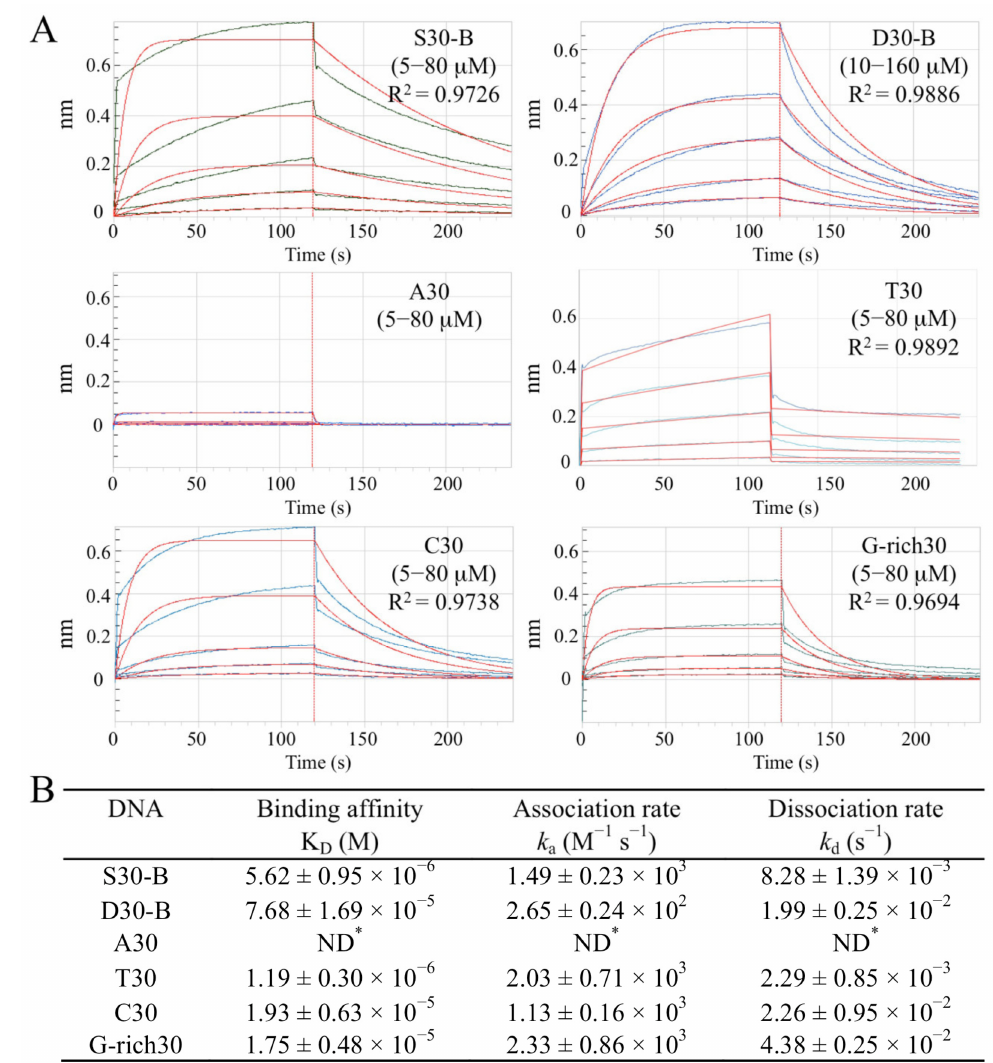
Figure 2. ss- and dsDNA binding properties of Sul7s. ( A ) BLI assays of Sul7s binding to the 30-nt oligonucleotides (S30, A30, T30, C30, and G-rich30) and the 30-bp DNA duplex D30 with the same sequence to S30. The R 2 value for each fit is indicated. ( B ) Kinetic parameters of the Sul7s binding ss- and dsDNA determined from three independent BLI experiments. ND, not